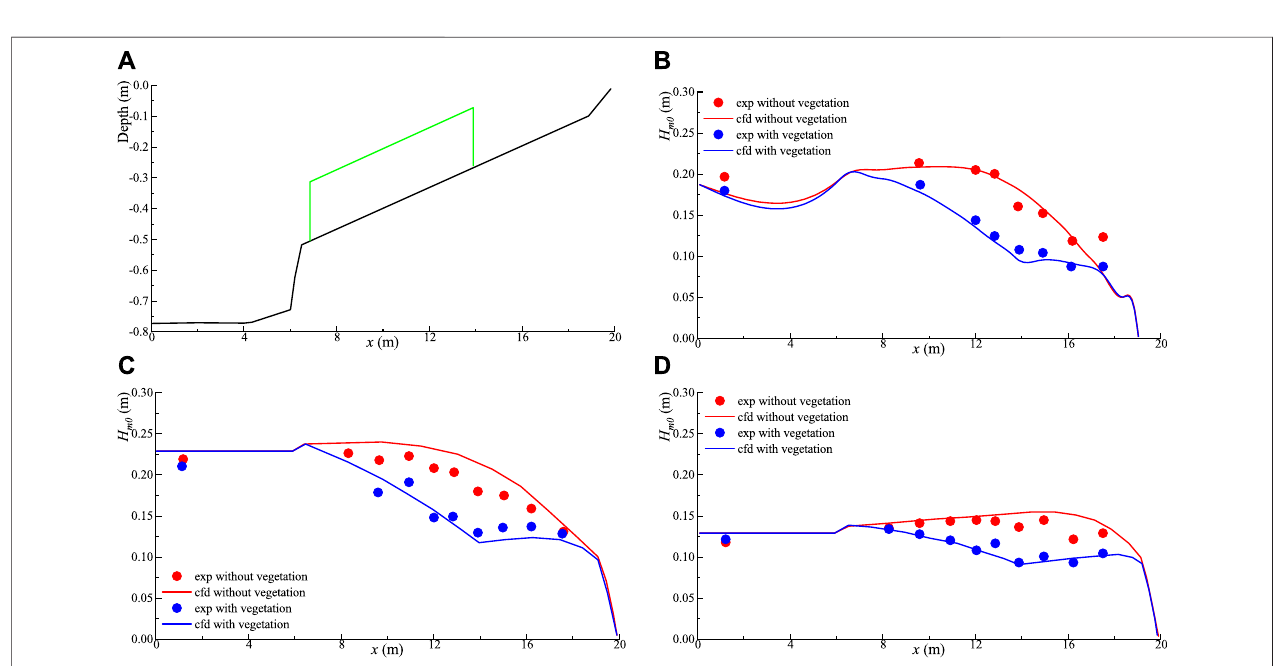
FIGURE2| Comparisonbetweennumericalsimulationandmodeltestonthein fl uenceofvegetationpatchesonbreakingwaveheight: (A) Bathymetry; (B) Case1; (C) Case2; and (D) Case3.